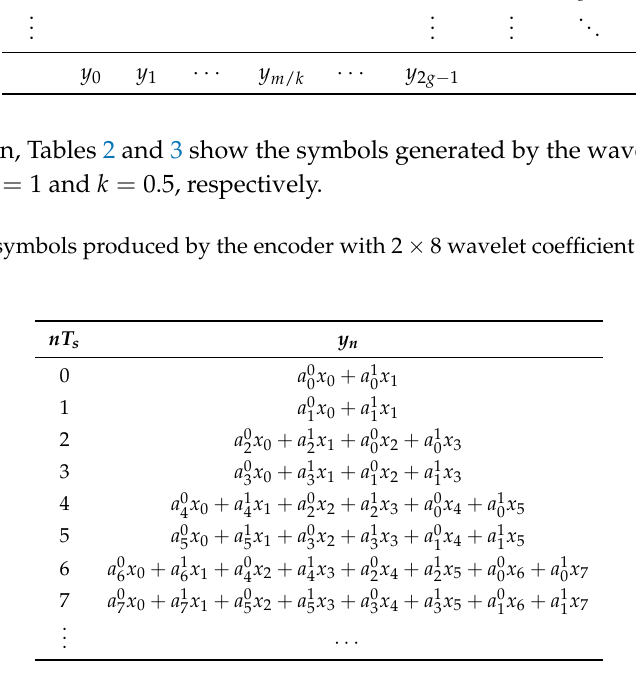
Table 3. Wavelet symbols produced by the encoder with 2 × 8 WCM for k =